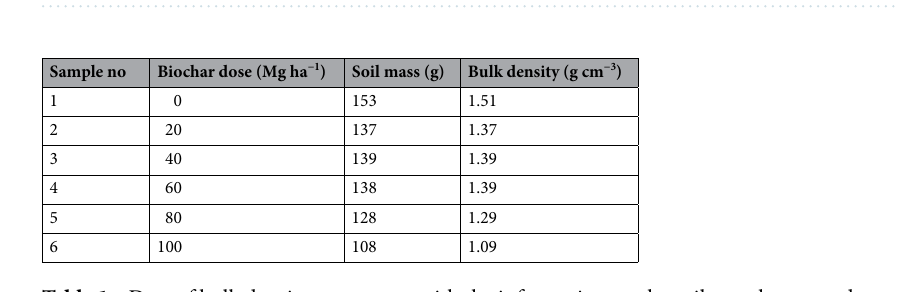
Table 1. Data of bulk density assessment with the information on the soil samples mass, depending on the biochar dose applied into the soil in the experimental fields. Bulk density values presented on the Fig. 4.